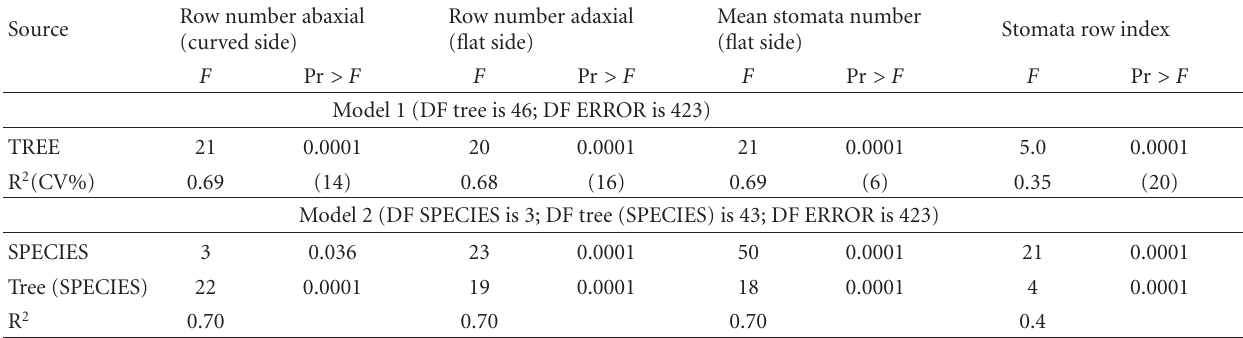
Table 4: Results of the ANOVA on the needle traits according the two models: No. 1 with tree as a single e ff ect and No. 2 with the e ff ects of species and tree nested within SPECIES in the model. DF is degrees of freedom. R 2 is proportion of variance explained by the model. CV is the coe ffi cient of